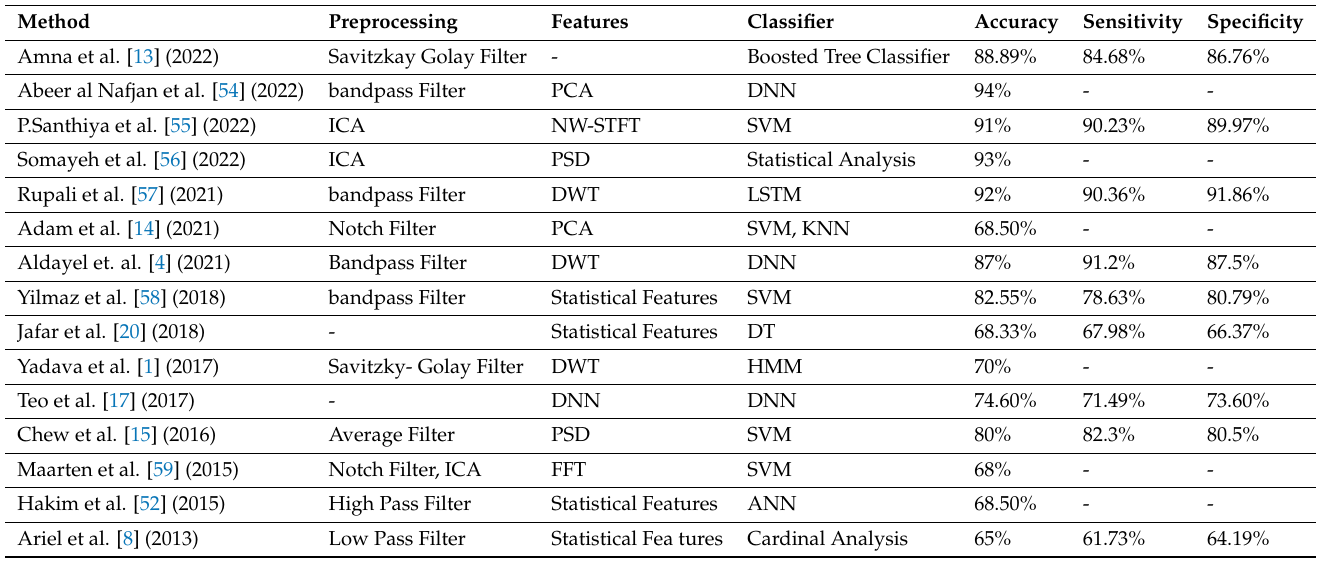
Table 1. Comparison of different state-of-the-art customer choice recognition systems.